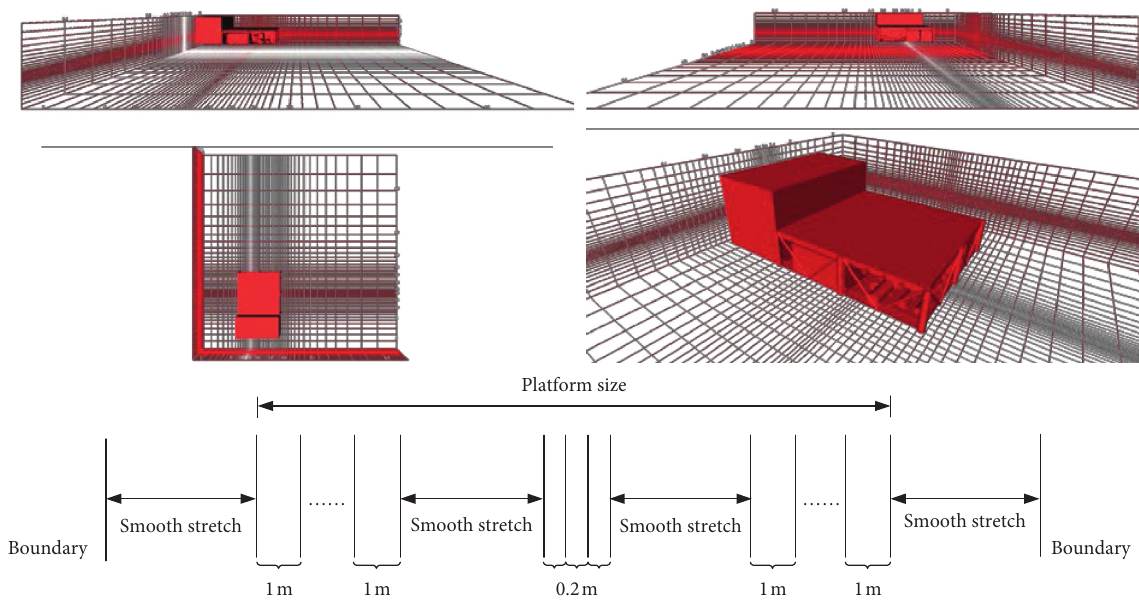
Figure 20: Typical grid solution for dispersion models. Table 4: Main dispersion parameter